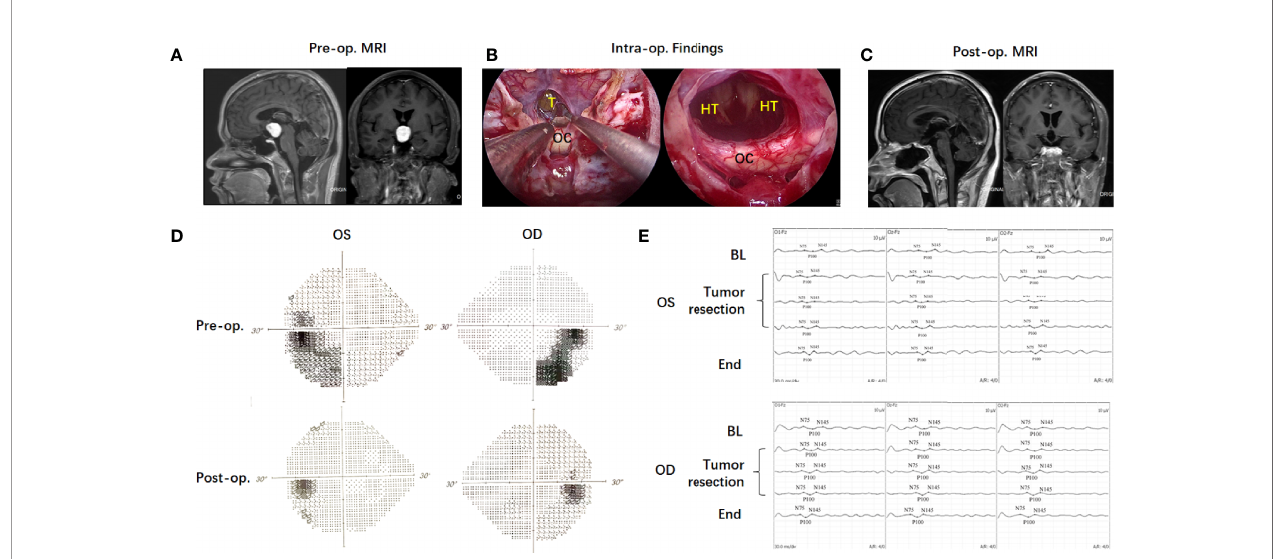
FIGURE 4 | Case illustration of endoscopic transnasal translamina terminalis approach. A 37-year-old male patient (Case 4) with a solid lesion located in the third ventricle in preoperative MRI (A) . Based on the NCL, the Supra-NCL part was over 90%. Translamina terminalis approach was used to remove the tumor (B) . Postoperative MRI showed the tumor was totally removed (C) . The intraoperative VEP monitoring showed the VEP amplitude (N75 to P100) was gradually reversed and fi nally improved in both sides of eyes after the tumor was totally removed (D) . Postoperative ophthalmic examination showed the visual fi eld improved signi fi cantly (E)